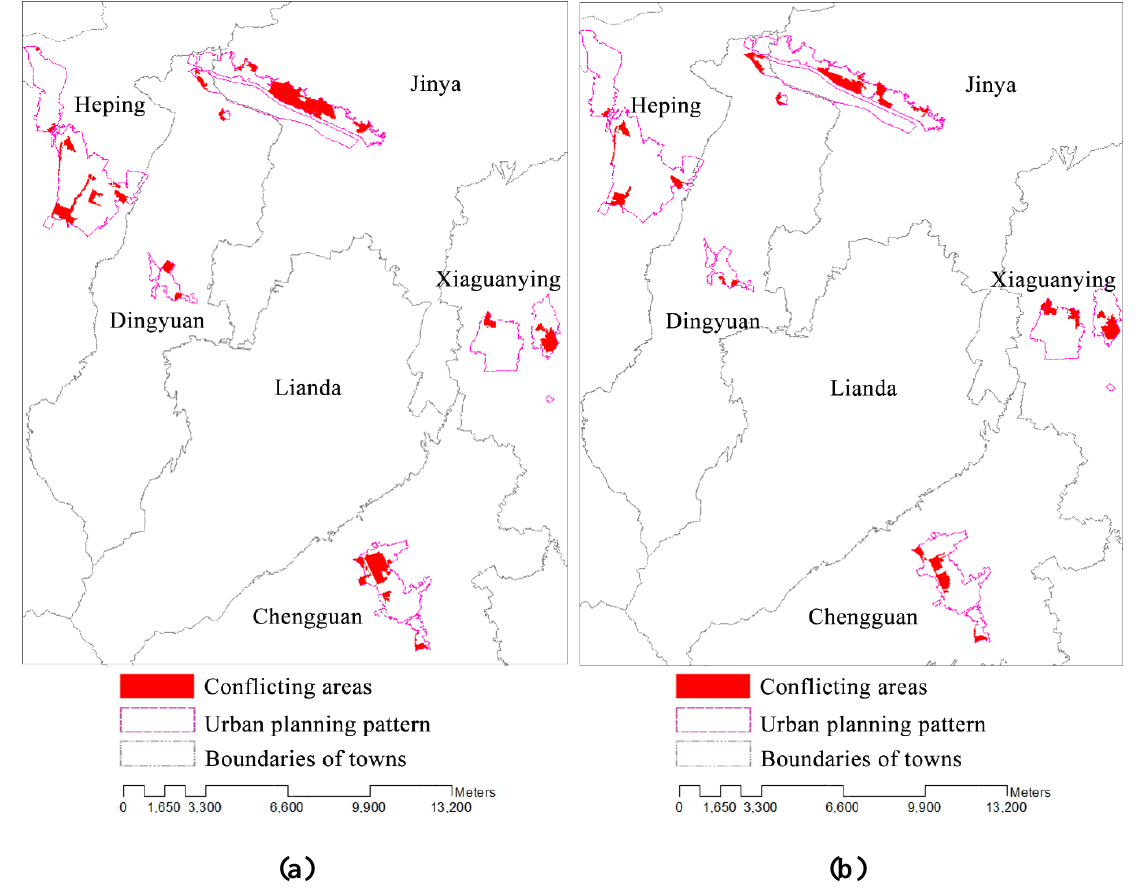
Figure 10. Conflicting areas for all the towns in Yuzhong